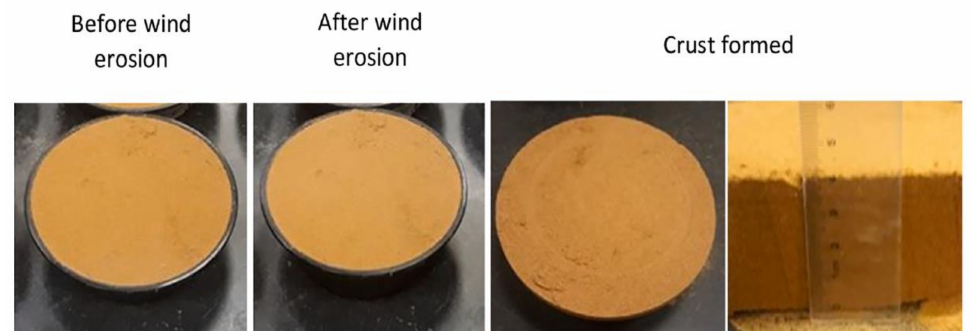
Figure 8. Crust formation of sand treated by sodium alginate biopolymer [145].